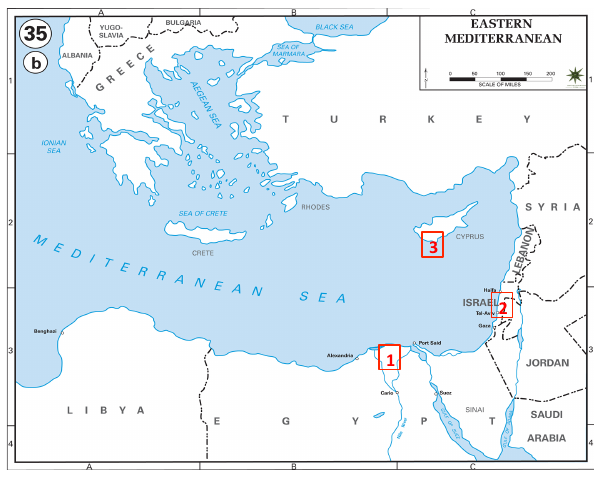
Fig. 1. The locations of the aquifers under study in the southeastern Mediterranean (1) Nile Delta aquifer, (2) Israel Coastal aquifer, and (3) Cyprus Akrotiri aquifer (adapted from http://www.emersonkent. com/map_archive/eastern_mediterranean.htm).